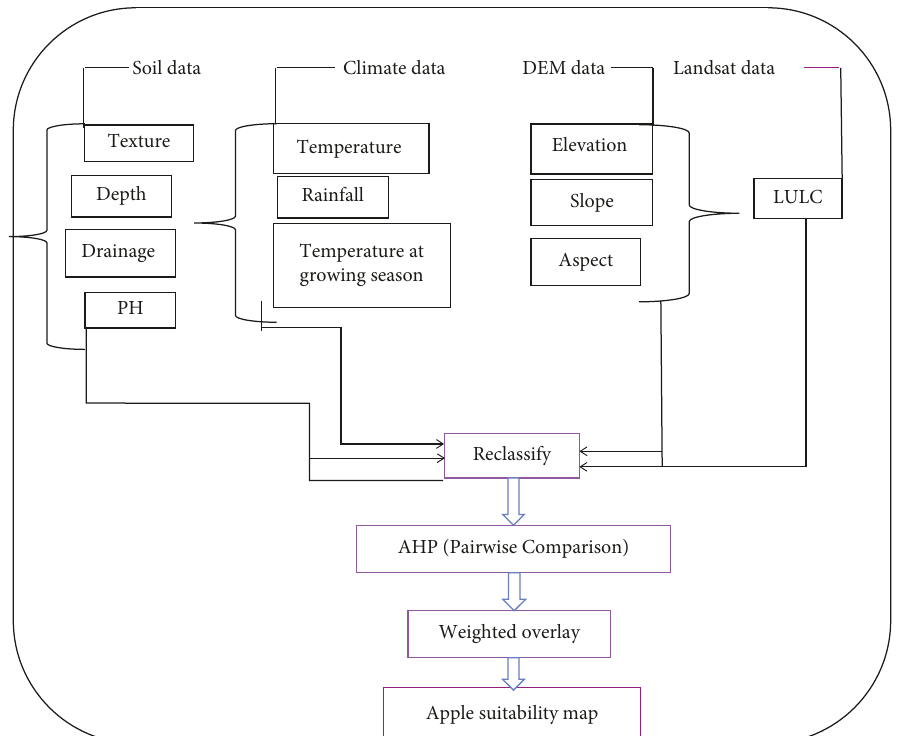
Figure 4: Flow chart of data collection and data analysis.